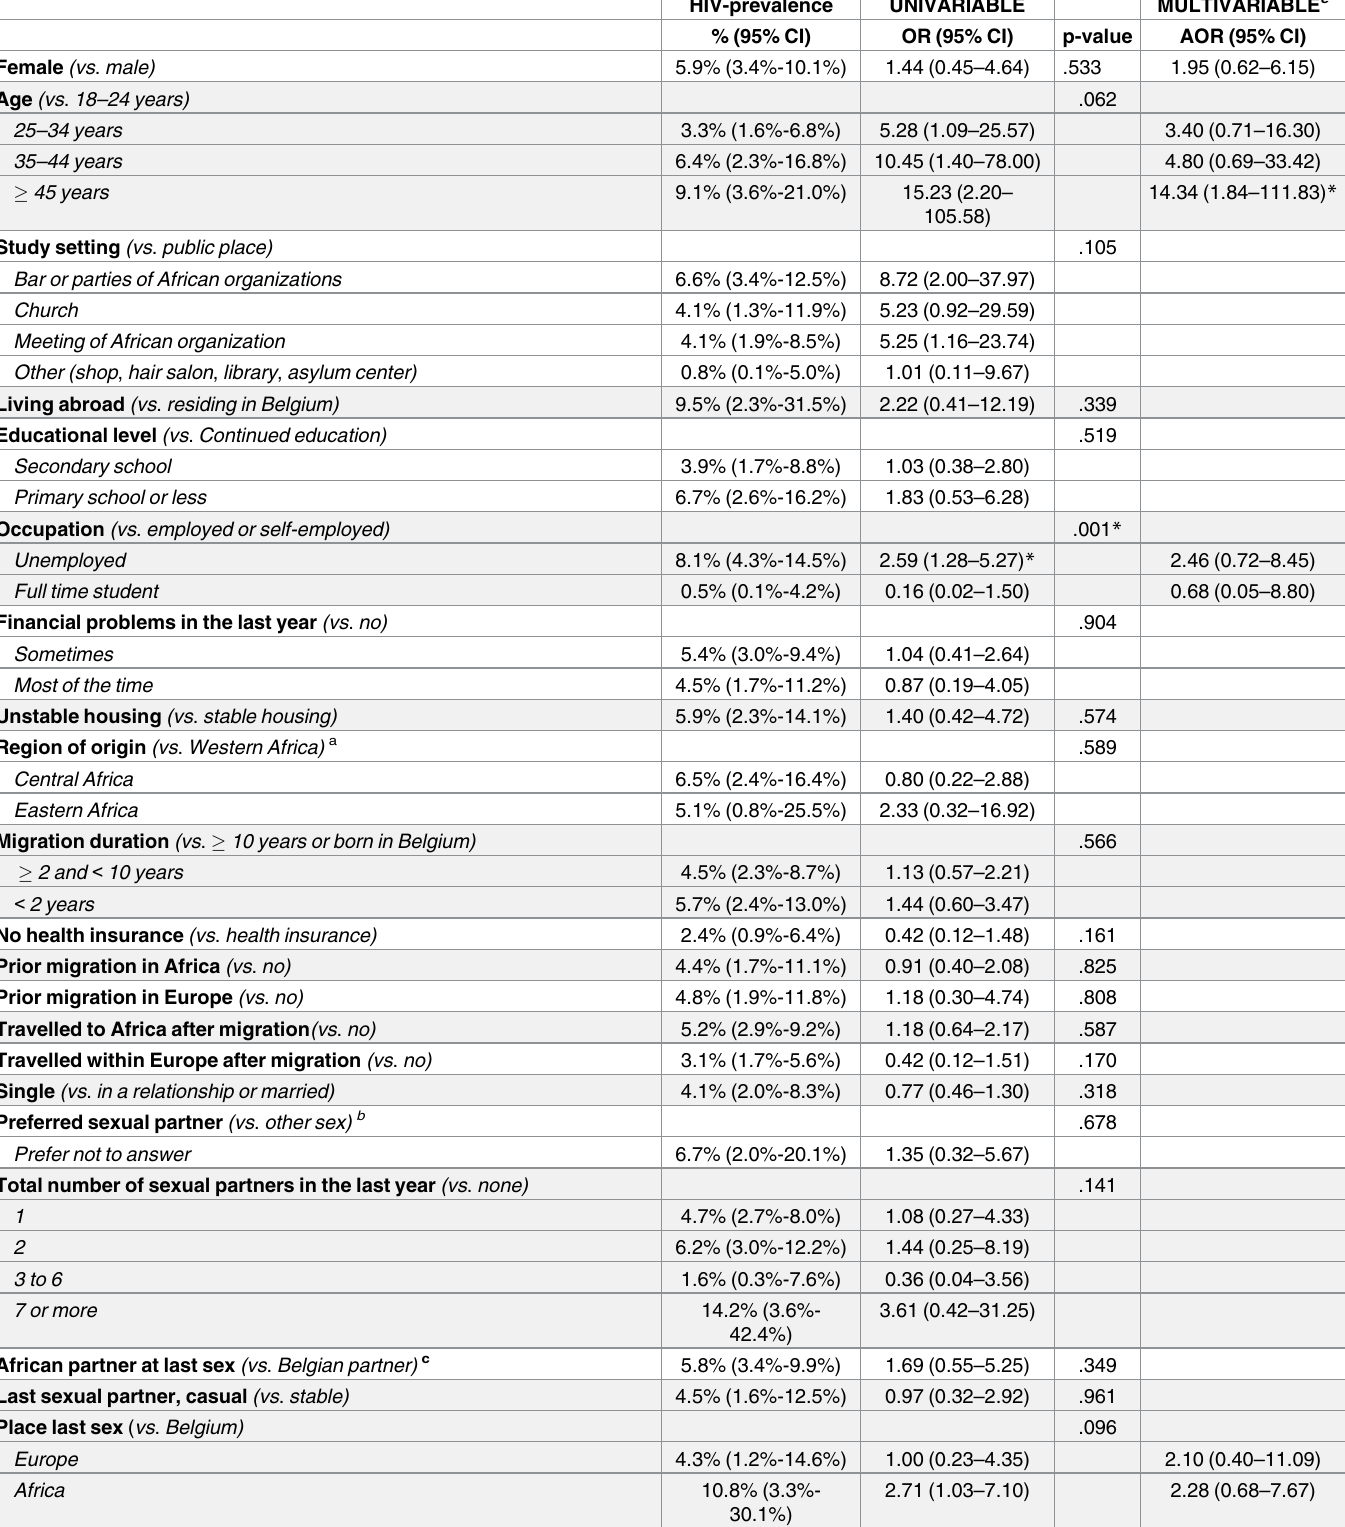
Table 5. Factors associated with HIV